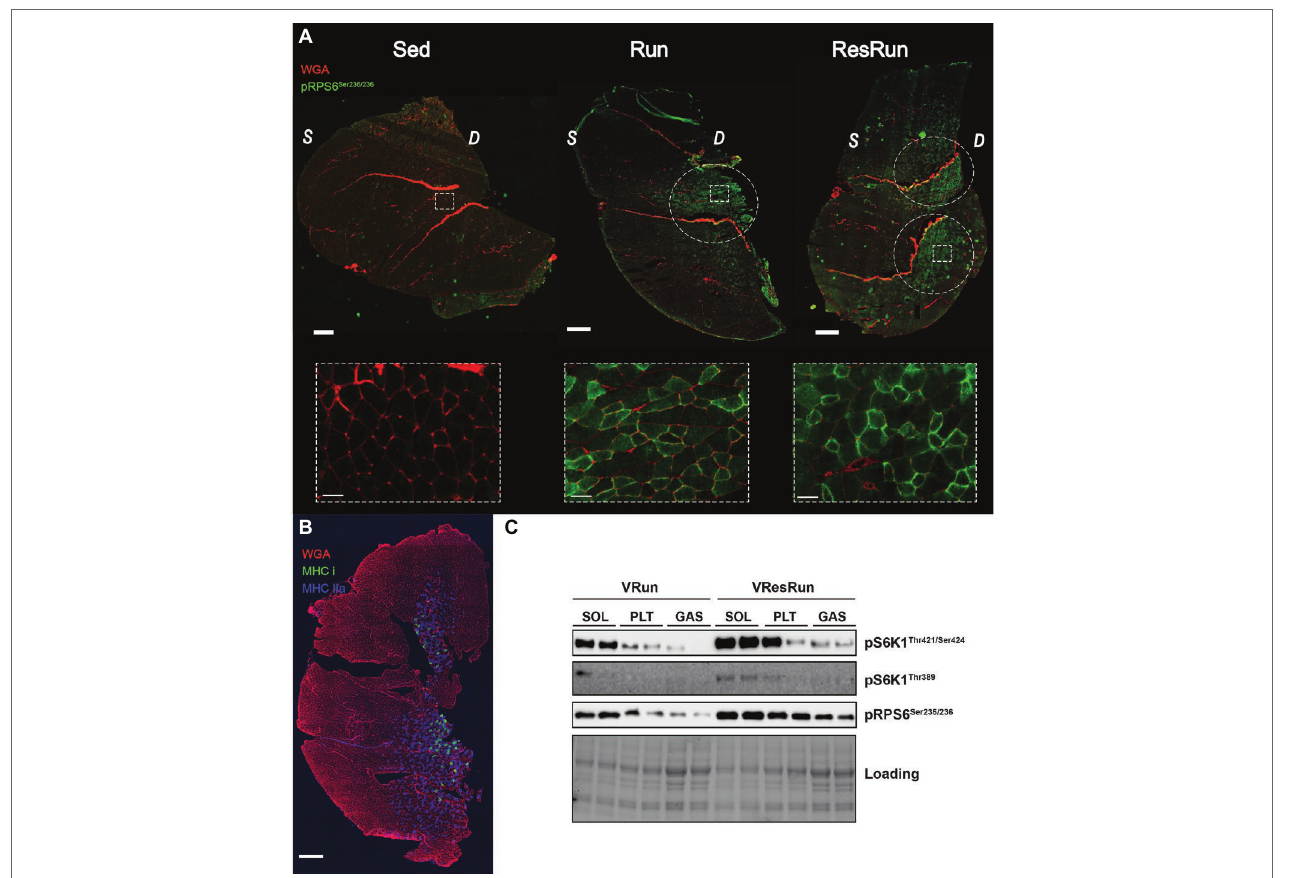
FIGURE 5 | (A) Representative immunofluorescence pictures of GAS in Sed, VRun, and VResRun with pPRS6 Ser235/236 in green and WGA in red. (B) Representative immunofluorescence staining of GAS with Myosin Heavy Chain type I in green, Myosin Heavy Chain type IIa in blue and Wheat Germ Agglutinin WGA in red. (C) Representative blots of downstream mTORC1 signaling (VRun and VResRun) in SOL, PLT, and GAS. Scale bar in tile scan represents 500 μm and scale bar in zoom-in represents 50 μm; WGA, wheat germ agglutinin; S, superficial part; D, deep